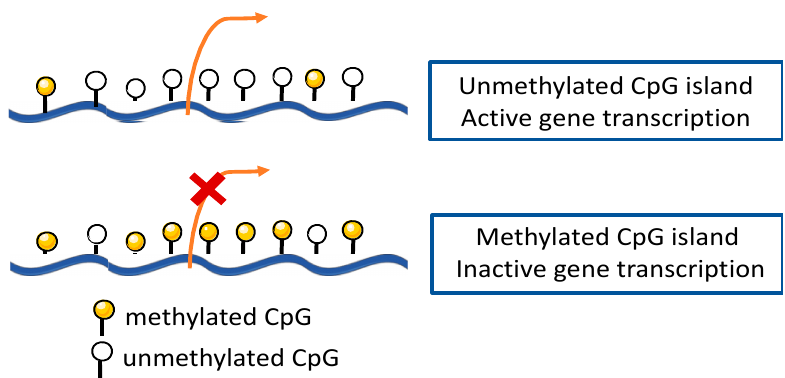
Figure 4. DNA methylation within a gene promoter region. Unmethylated CpG islands enable gene transcription. When CpG island is methylated, gene transcription is repressed.